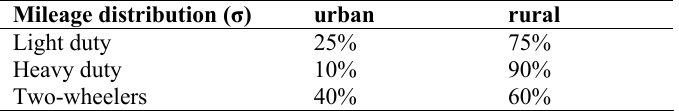
Table 3. Overview of mileage distribution for different vehicle categories Mileage distribution ( σ ) urban rural Light duty 25% 75% Heavy duty 10% 90% Two-wheelers 40%